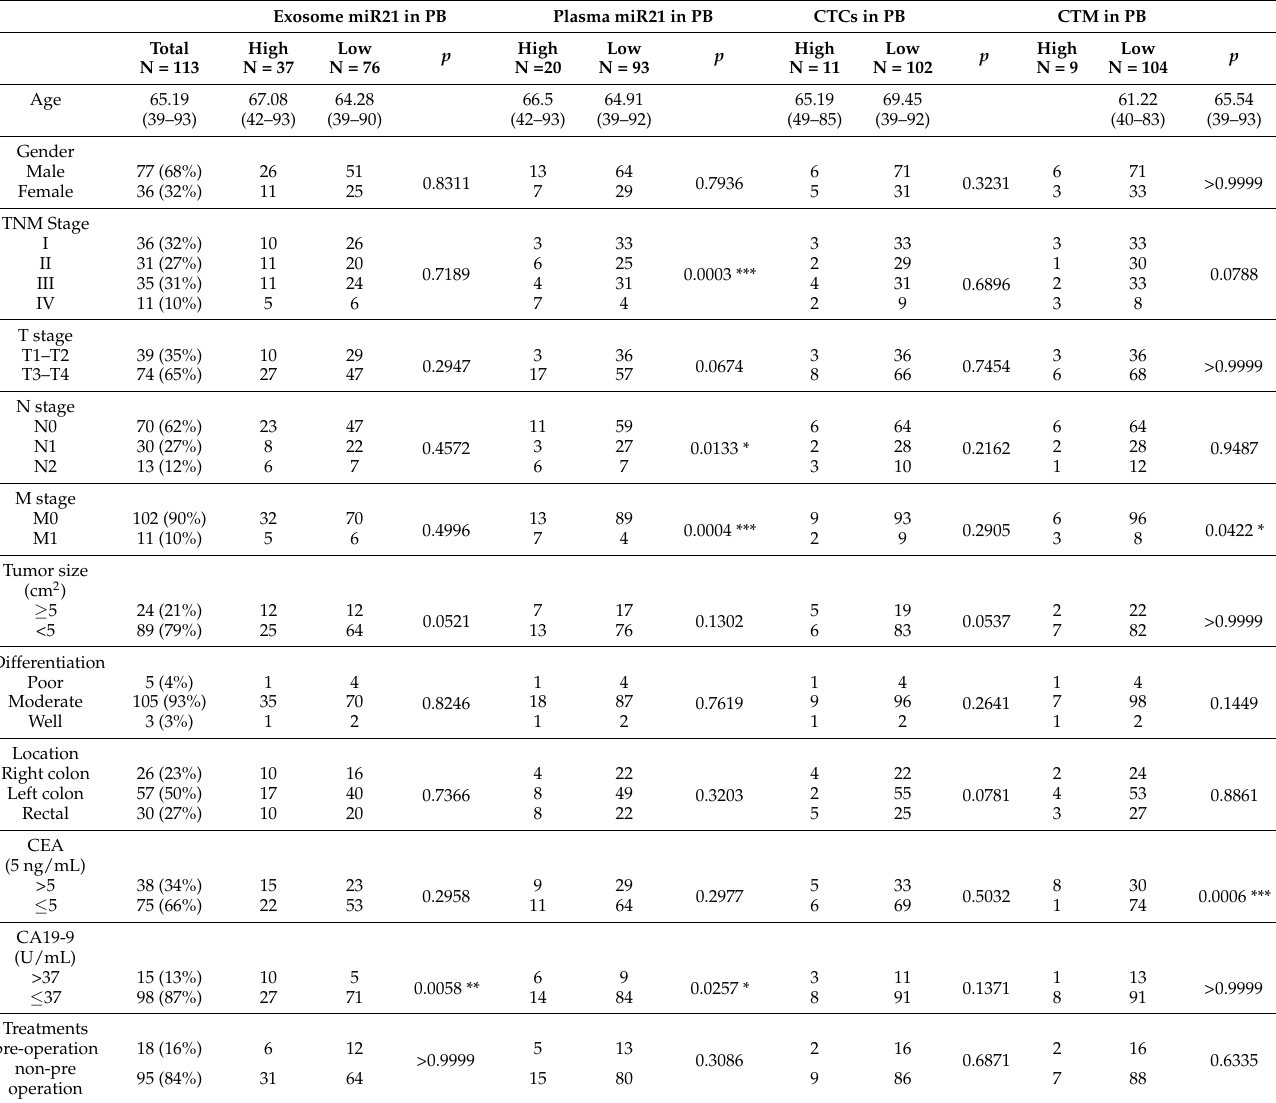
Table 1. Preoperative demographics, classifications, and pathological parameters of 113 CRC